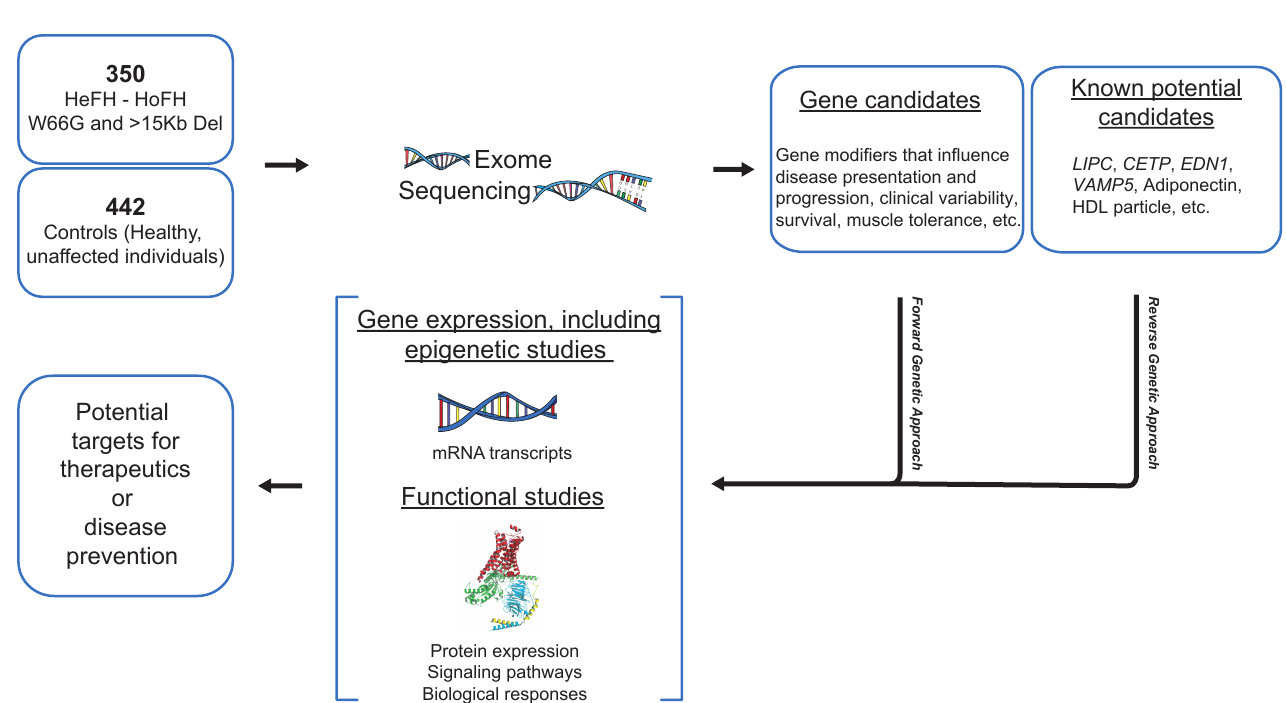
Figure 3. Ongoing exome sequencing analyses to identify genetic factors of CVE-free survival in FH. EDN1: Endothelin-1, CETP: Cholesteryl ester transfer protein, LIPC: Hepatic Lipase C, VAMP5: Vesicle associated membrane protein